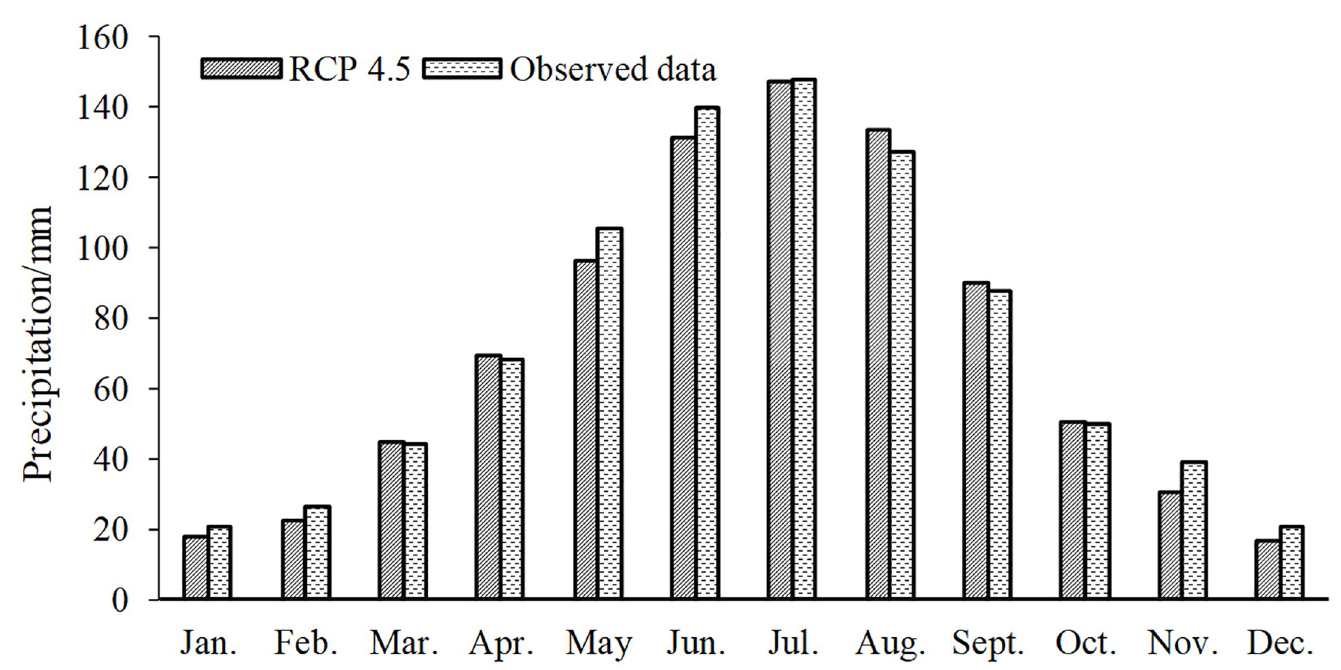
Fig 1. Relationship of the estimated and observed monthly precipitation.